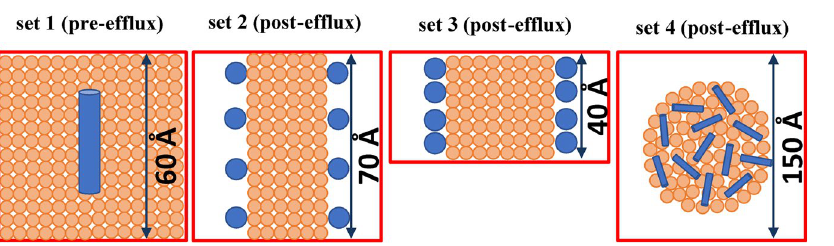
Figure 6. MD simulations of ELKs. Schematic top-down view of initial conditions in Set 1 (surface-bound), Set 2 (edge-bound, low density), Set 3 (edge-bound, high density), and Set 4 (nanodisc). Lipids, peptides, and box boundaries are shown in orange, blue, and red, respectively. Peptides are represented as cylinders (when perpendicular to bilayer normal) or circles (when parallel to bilayer normal). Boxes of Set 1, 2, and 4 are cubic. Box of Set 3 is tetragonal. All systems are hydrated with water and